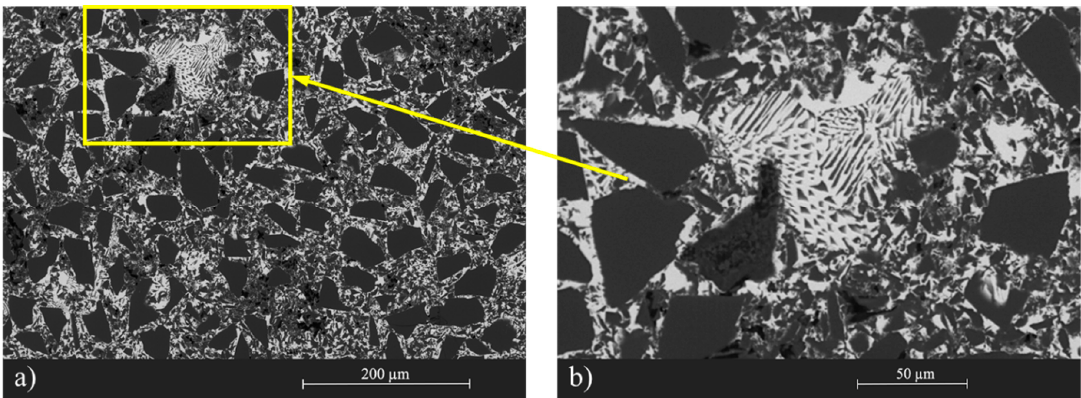
Figure 2. ( a ) Microstructure of the SiC-Si-IrSi3 composite material obtained by SEM; ( b ) detail of the eutectic microstructure.